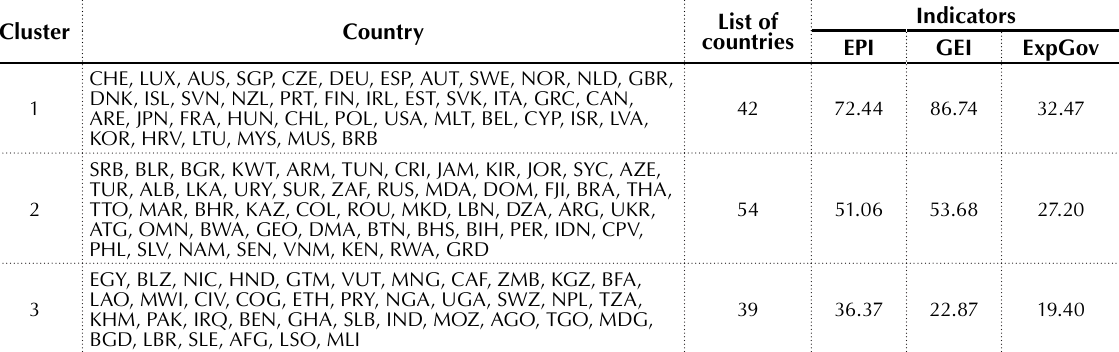
Table 3. Composition and average values of country clusters* by the environmental state, the efficiency of governance and the share of government expenditures in